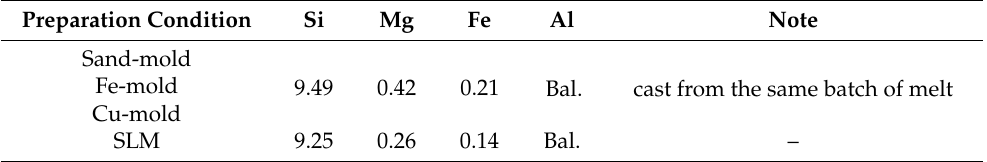
Table 1. Compositions (wt.%) of Al-10Si-0.5Mg alloys analyzed with ICP-AES. Preparation Condition Si Mg Fe Al Note Sand-mold 9.49 cast from the same batch of meltFe-mold Cu-mold